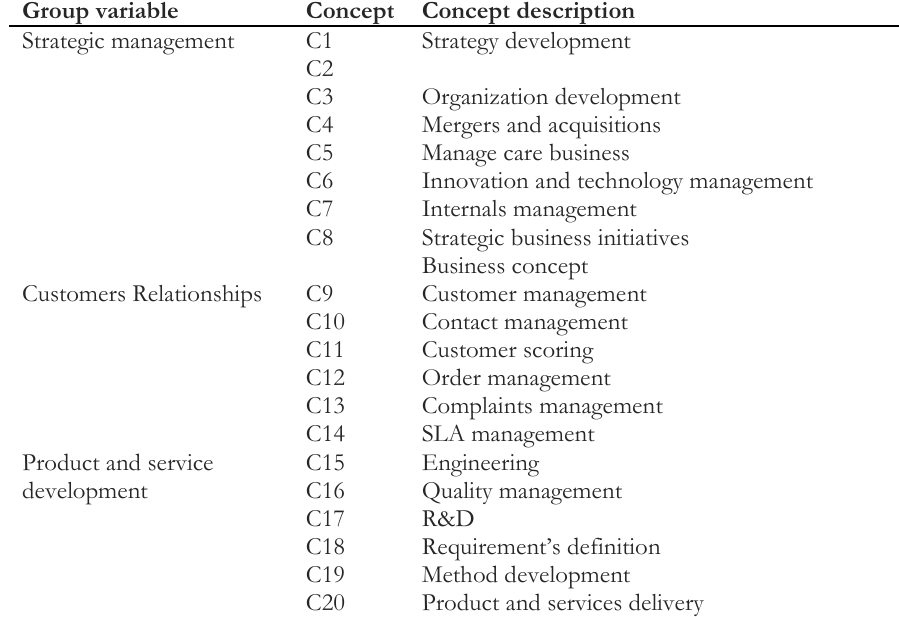
Table 2. List of concepts used in the